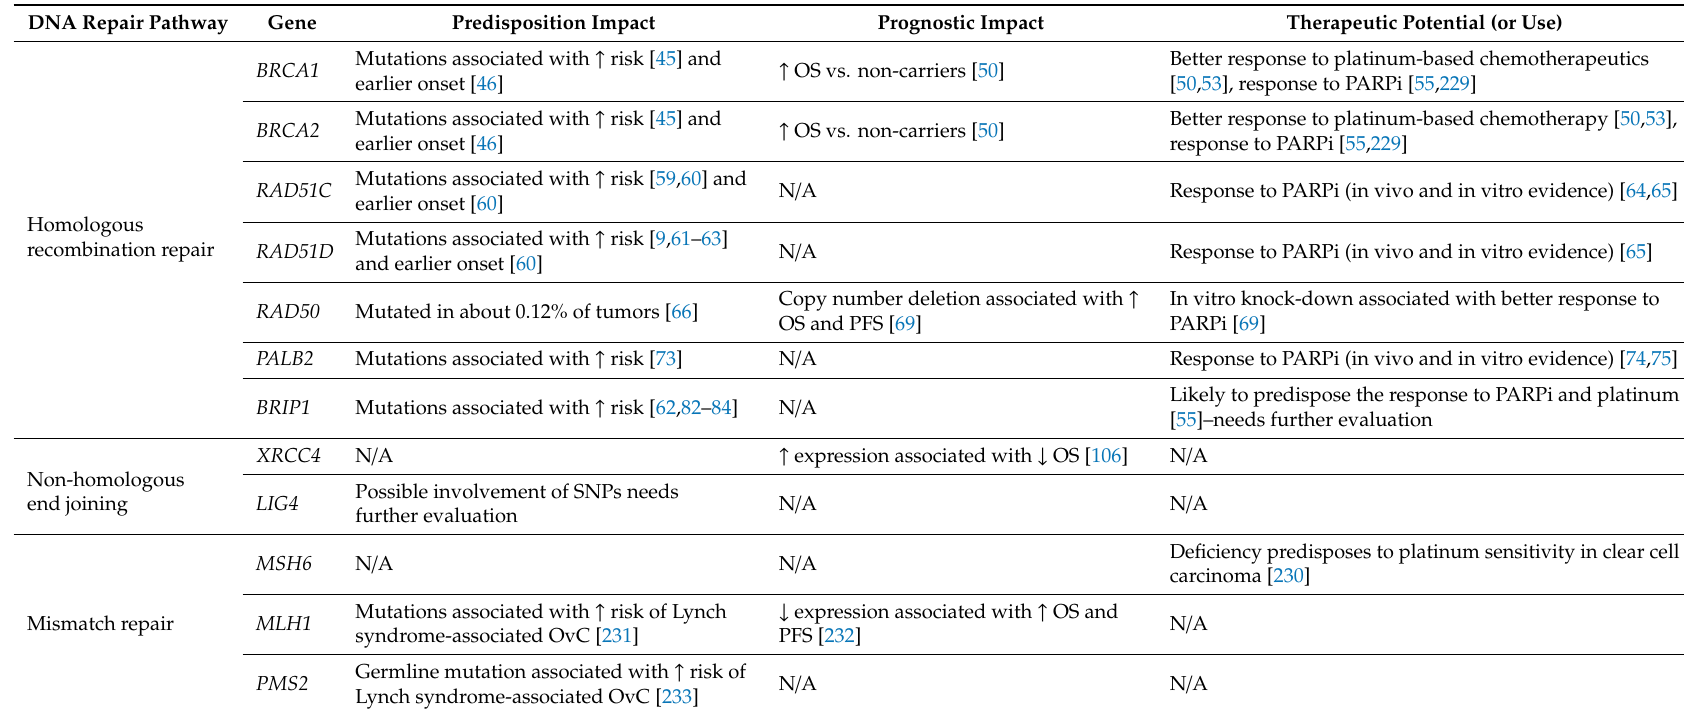
Table 3. Overview of the most important DNA repair genes, their predisposition and prognostic impact and potential therapeutic use in targeted therapy for OvC. Symbols: ↑ means higher, or better; ↓ means lower, or worse. Protein names: breast cancer 1 and 2 (BRCA1 and 2), RAD51 paralog C and paralog D (RAD51C and D), RAD50 homolog 1 (RAD50), partner and localizer of BRCA2 (PALB2), BRCA1-interacting protein C-terminal helicase (BRIP1), PMS1 homolog 2 (PMS2), X-ray